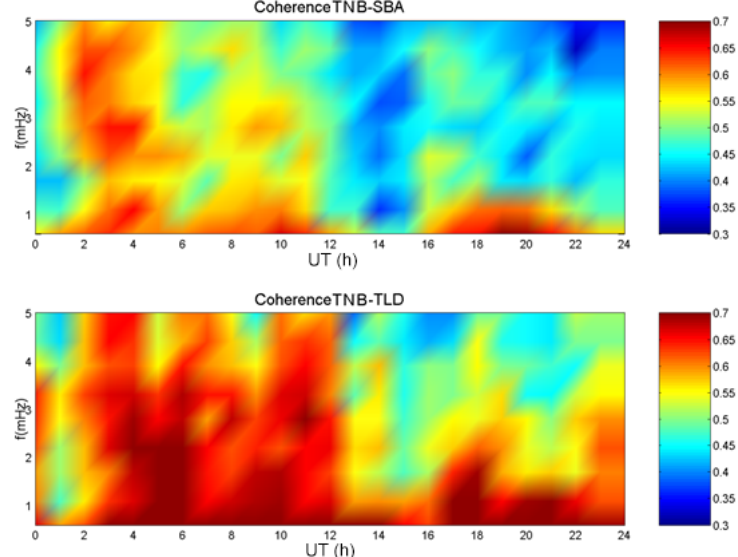
Figure 7. Average coherence between H component fluctuations at pairs of stations.